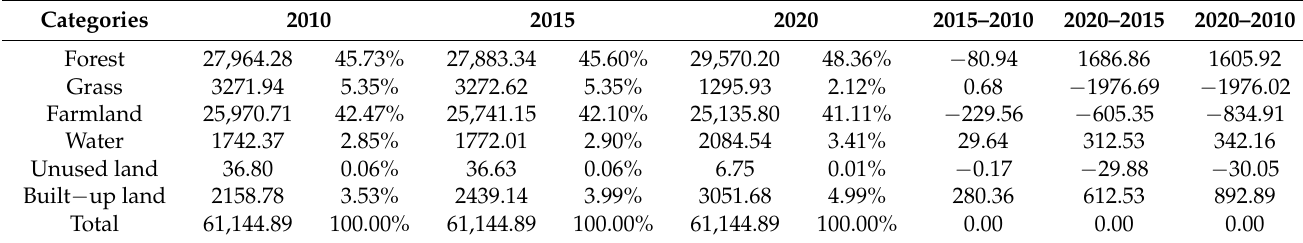
Table 3. Area change according to land cover types in 2010, 2015, and 2020 (km 2 ).